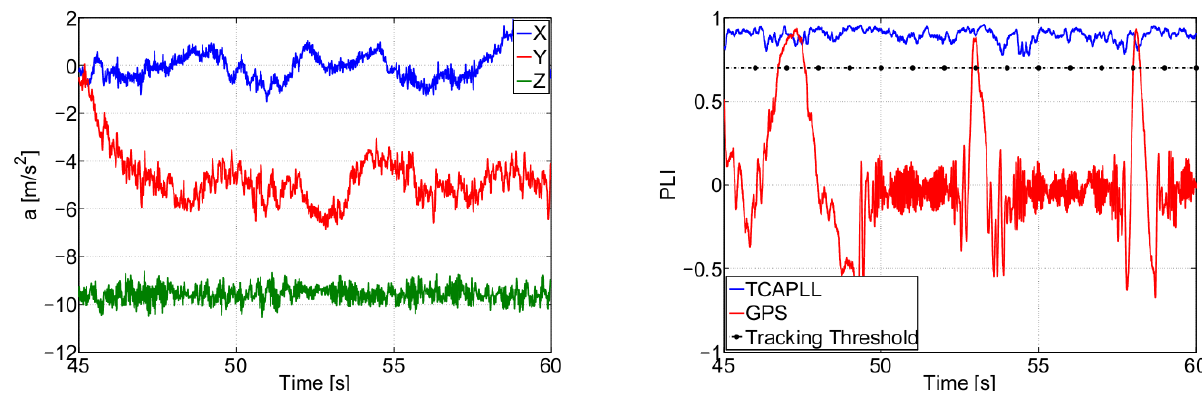
Figure 32. PLI output of SV 19 during high dynamics in Trajectory 1 when B TCAPLL and 7 Hz for GPS